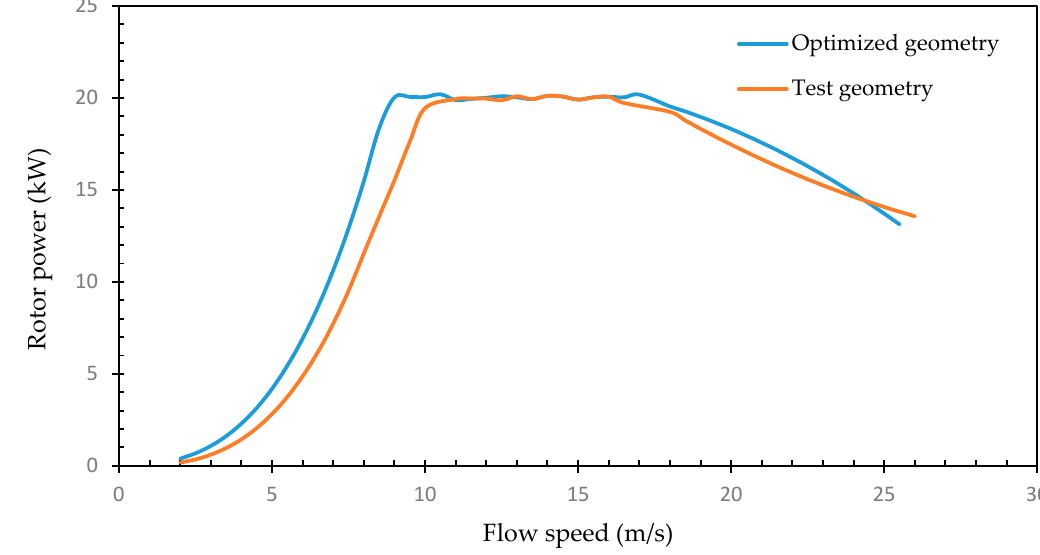
Figure 14. Power output of the reference tested rotor and optimized